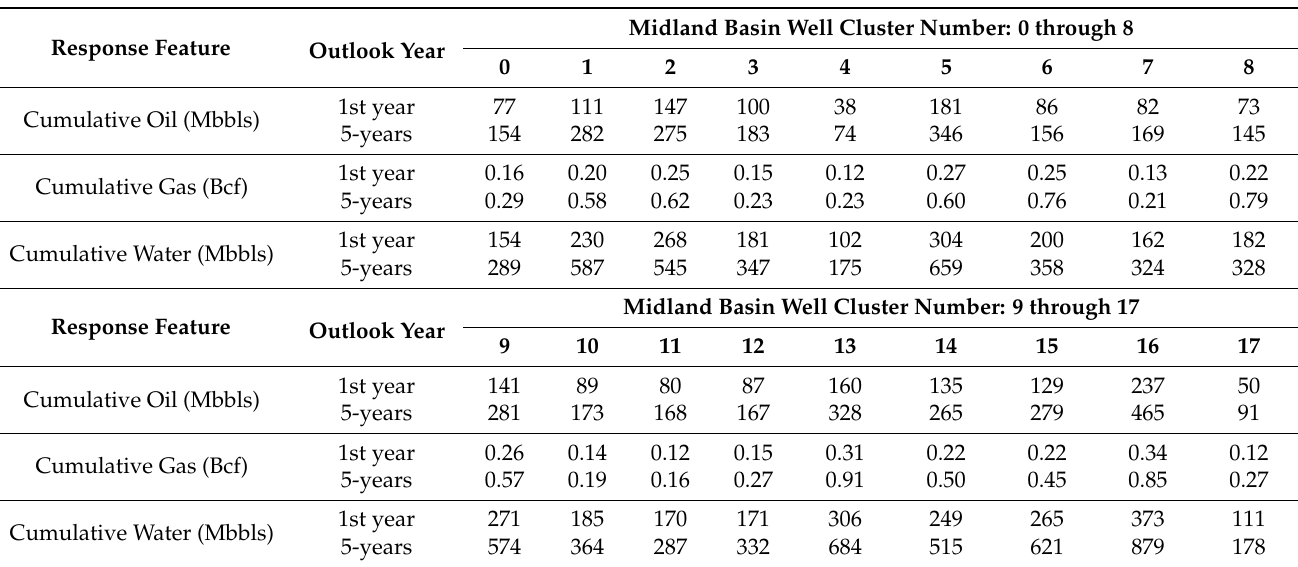
Table 6. Inventory of first year and cumulative five-year production estimates for a hypothetical representative well within each Midland Basin Well Cluster.